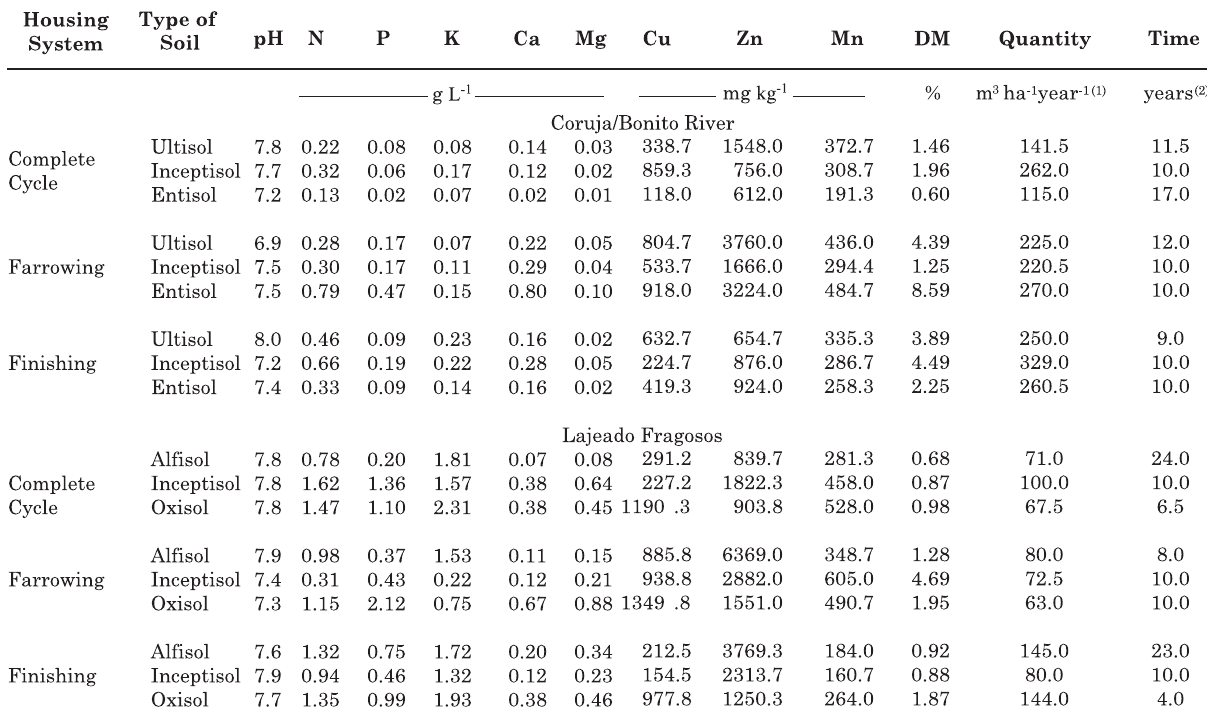
Table 2. Mean values of pH and of N, P, K, Ca, Mg, Cu, Zn, and Mn contents in the pig slurry applied, of the quantities of pig slurry applied per year and of the time of application in the watersheds and pig production systems